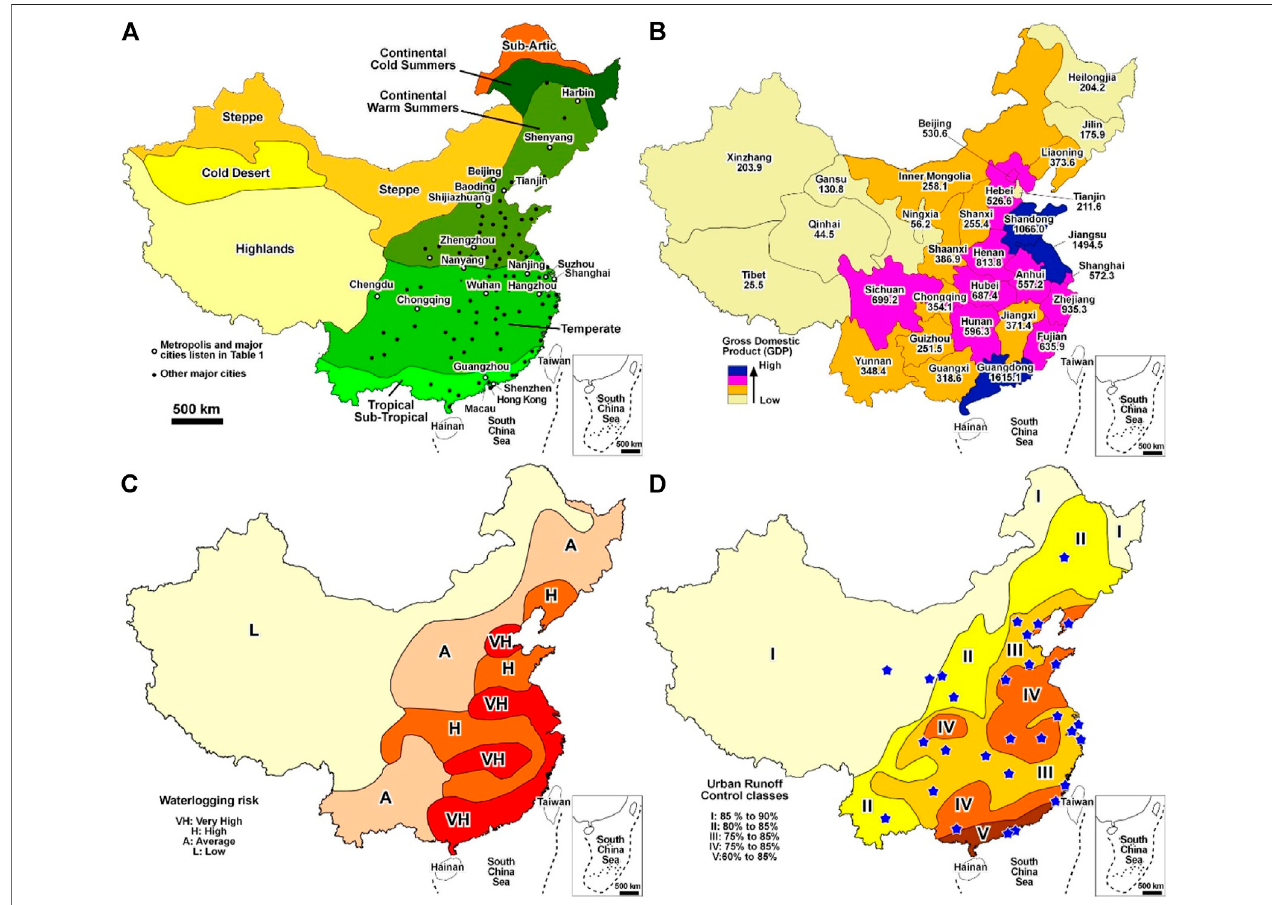
FIGURE 1 | Climate distribution of China and major cities (A) ; province Gross Domestic Product [$] (B) ; waterlogging risk (C) ; urban runoff control classi fi cation according to MOHUD (2014) with mandated percentage goals for collection and reuse, blue stars indicate the Sponge City pilot areas (D) .